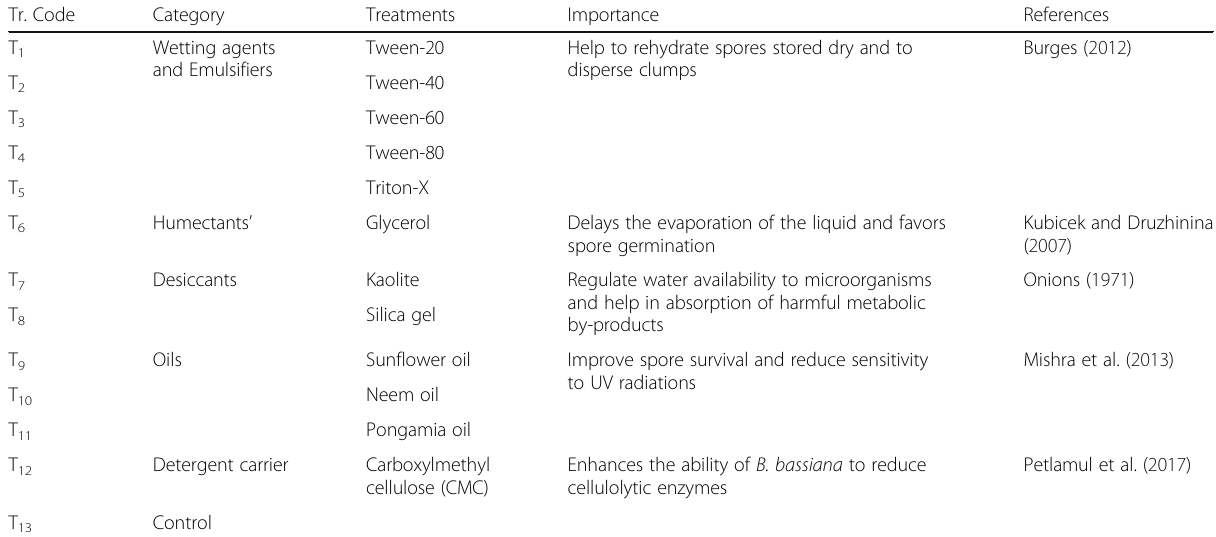
Table 1 Additives for compatibility studies of B. bassiana Tr.